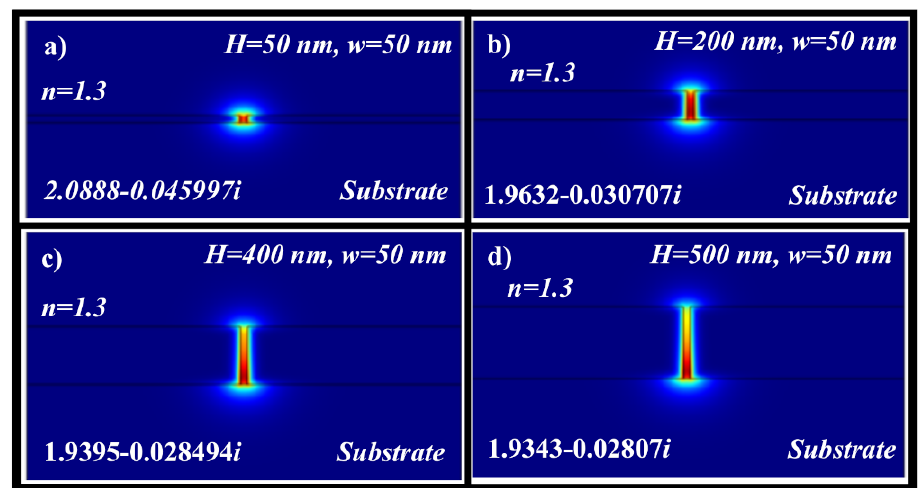
Figure 3. Normalized H-field distribution in the MIM WG at the operation wavelength of 1000 nm: ( a ) H = 50 nm, w = 50 nm, ( b ) H = 200 nm, w = 50 nm, ( c ) H = 400 nm, w = 50 nm, ( d ) H = 500 nm, w = 50